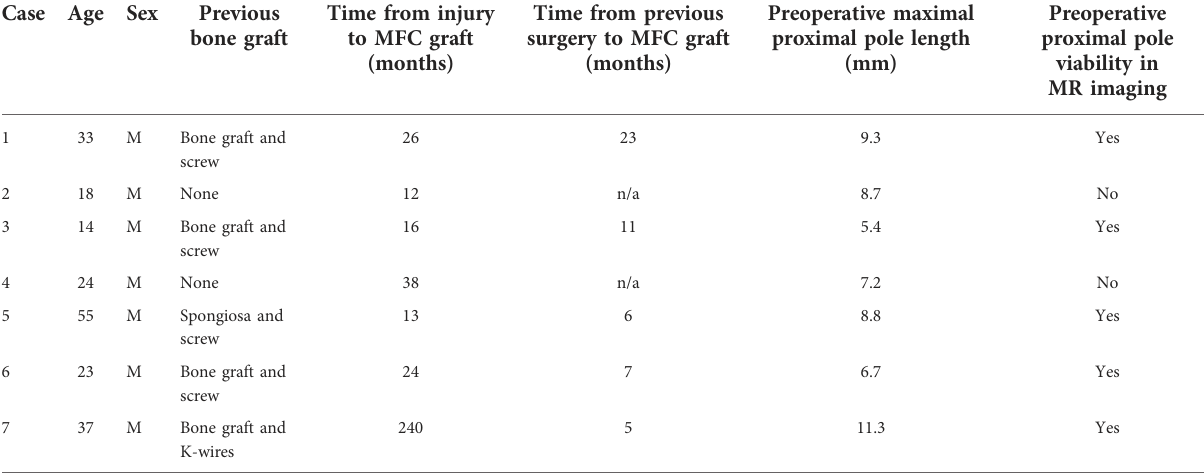
TABLE 1 Patients ’ characteristics and the types of previous surgical